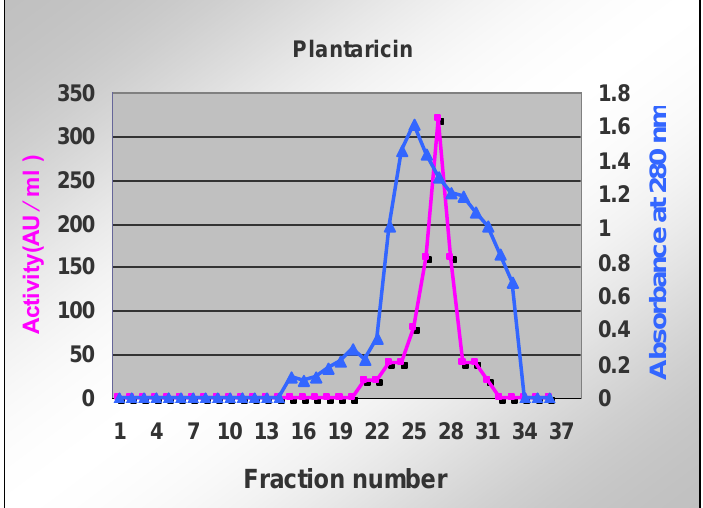
Figure (1) : Purification of plantaricin by gel filtration chromatography), using Sepharose 6B column with dimensions (1.5x64) cm, that equilibrated and eluted by 20mM sodium citrate buffer (pH 5), flow rate was 40ml/hour, with 5ml for each fraction. Table (2): Steps of purification of plantaricin produced by Lactobacillus plantarum